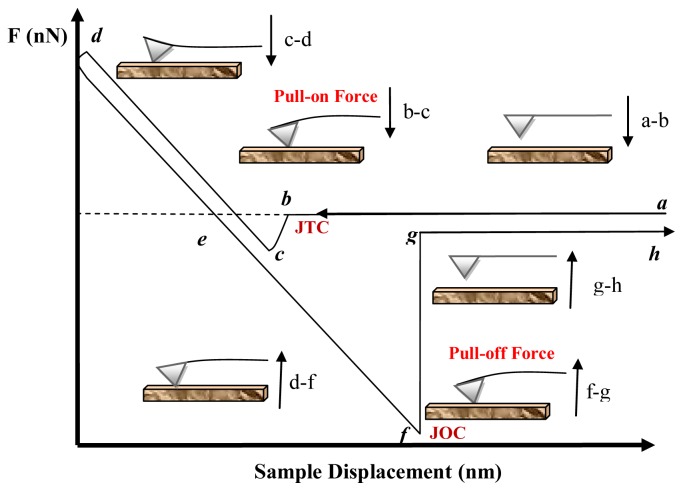
Force curve on a wood surface illustrating the points where jump-to-contact (JTC) (approach) and jump-off-contact (JOC) (withdrawal) occur and the maximum values of the attractive force (pull-on force and pull-off force).